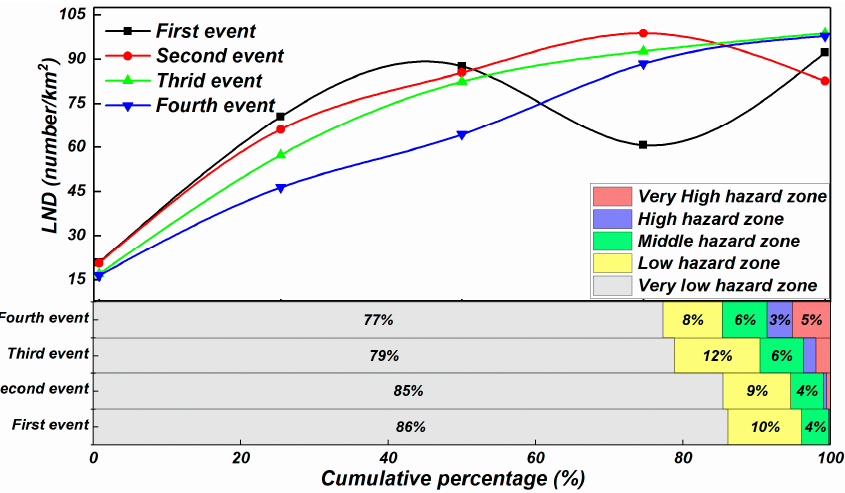
Figure 14. The predicted hazard zoning results and the landslide number density (LND) distribu- tion under four rainfall events. under four rainfall